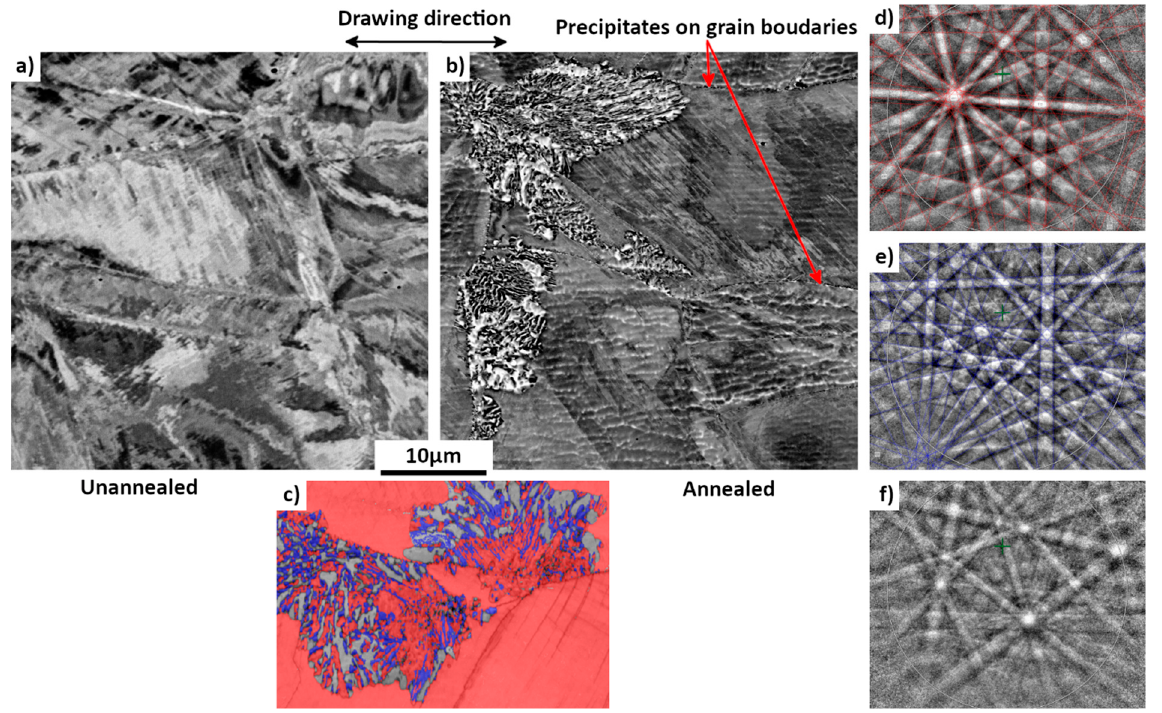
Figure 6. SEM BSE micrographs of differently treated samples. ( a ) as-received sample (25%-drawn). ( b , c ) 25%-rolled sample after 978h annealing at 575 °C. ( c ) SEM EBSD micrograph. In ( c ) red: austenite phase, blue: Cr 2 N and gray (band quality indexed contrast): unknown phase. Corresponding EBSD Kikuchi patterns of the three phases: ( d ) austenite, ( e ) Cr 2 N, ( f ) unknown phase. For austenite and Cr 2 N, calculated line patterns are superimposed on experimentally acquired patterns showing the excellent fit of the two.